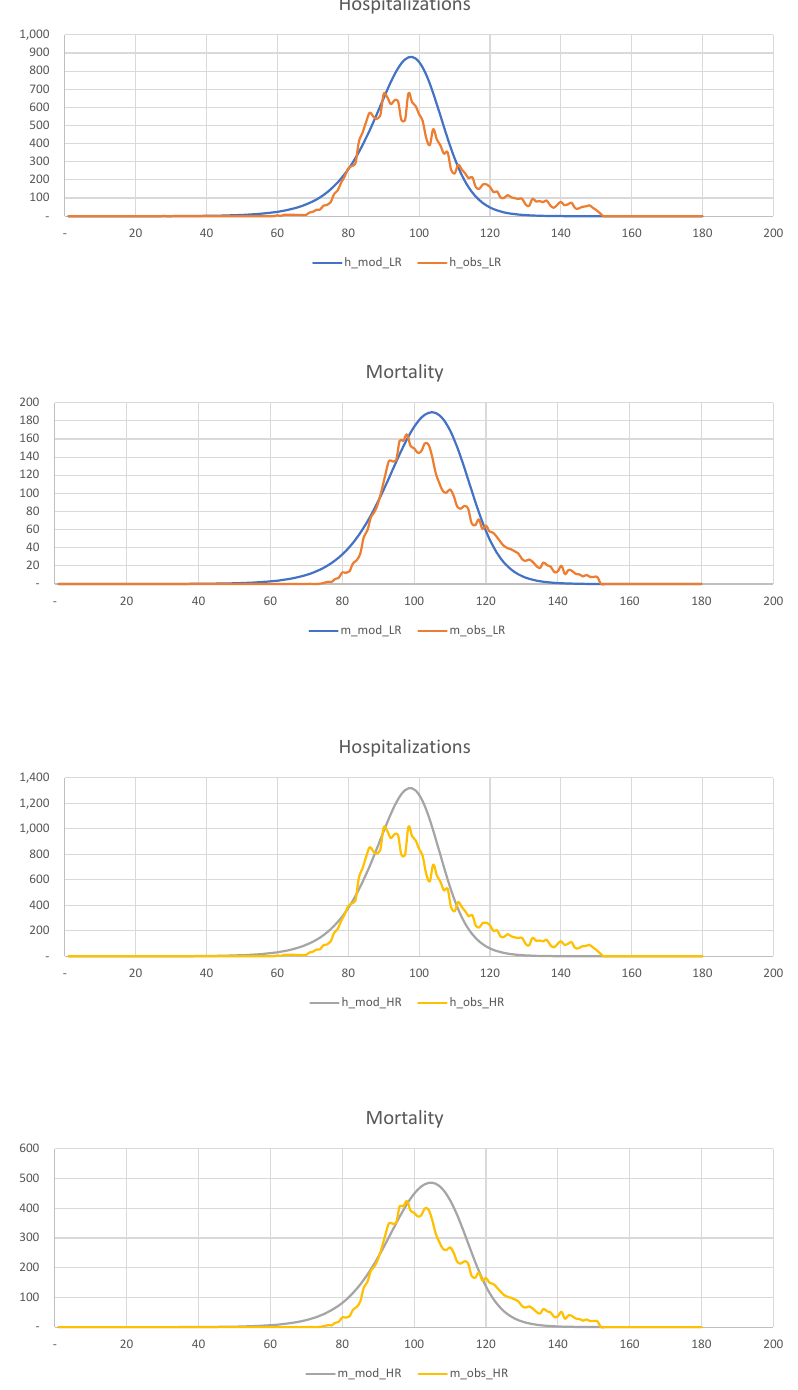
Figure 21. Hospitalization and mortality assuming that there is no